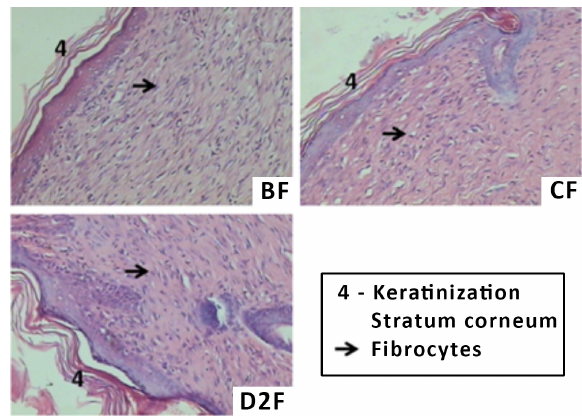
FIGURE 5 - Histological analysis on 21st day of treatment of skin wounds in rats. Key: BF - collagenase, CF – natural PALY, D2F – PALY-BKC, F –